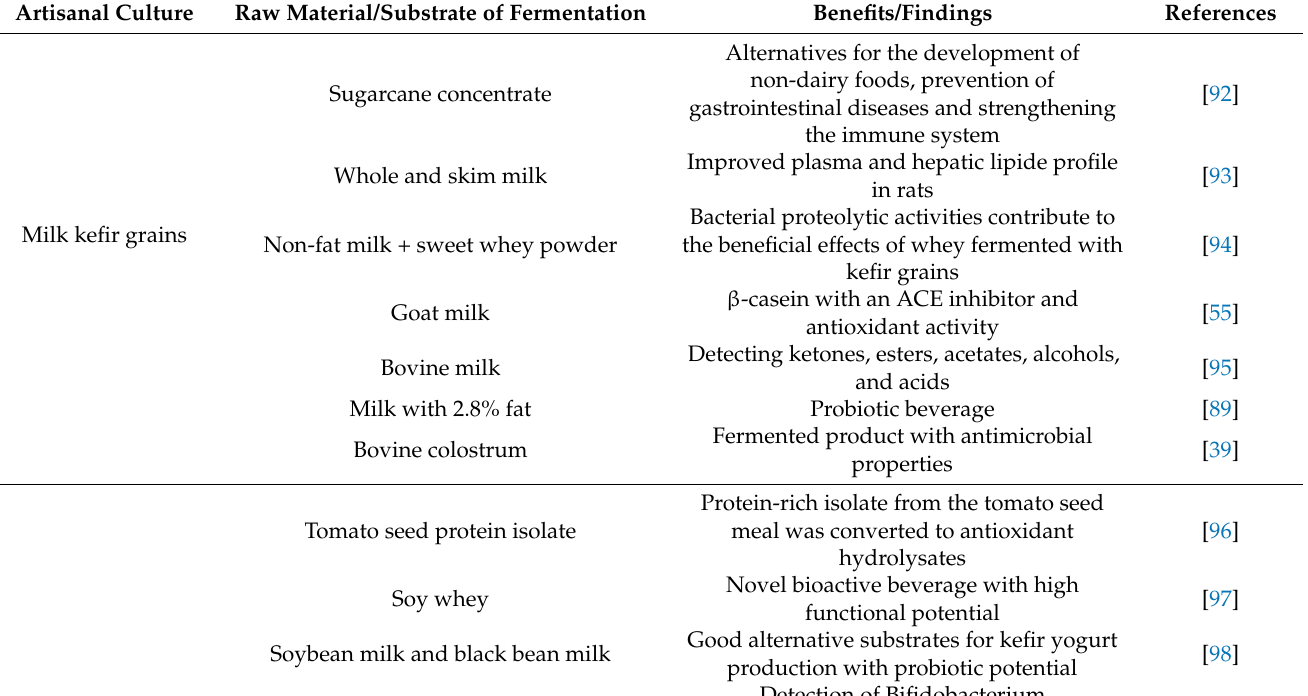
Table 2. Unconventional substrates used for the fermentation with artisanal